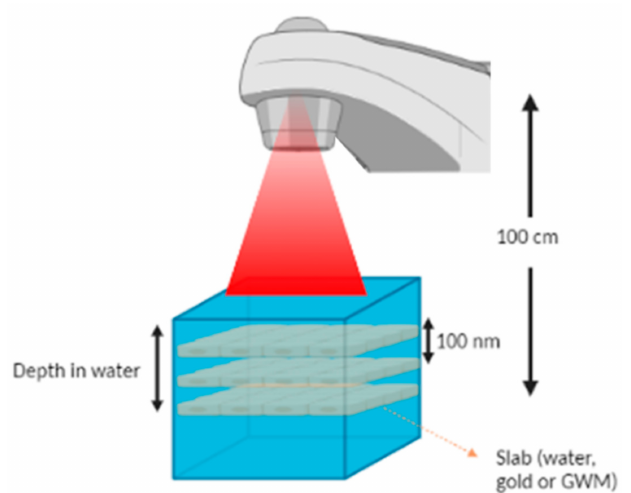
Figure 1. A graphical representation of the simulated irradiation geometry. The TrueBeam ® linac beam, the water phantom and the AuNPs clusters are depicted. Source to cluster distance (or to the last one in case of multiple clusters) was kept constant at 100 cm in all simulations. The distance between multiple clusters was set to 100 nm. Investigated depths of the slab in water were equal to 2 cm, 5 cm and 10 cm. Field sizes of 5 × 5 cm 2 and 10 × 10 cm 2 were examined. Created with